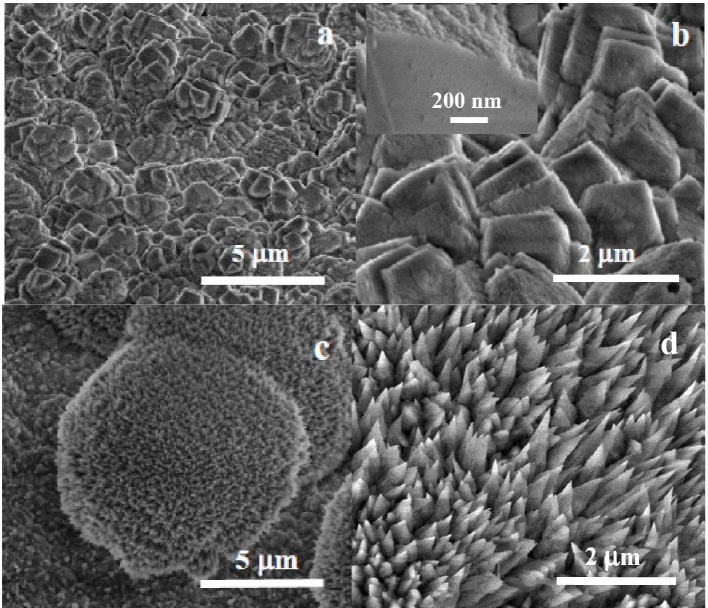
Figure 7. SEM micrographs at different magnifications of Mg disks after ( a , b ) 1 h and ( c , d ) 1 -week immersion, showing rhombohedral calcite crystals ( a , b ) with a nanocrystalline mosaic pattern visible on the facets of growing calcite crystals (inset in ( b )) and colonies of aragonite needle-like crystallites.